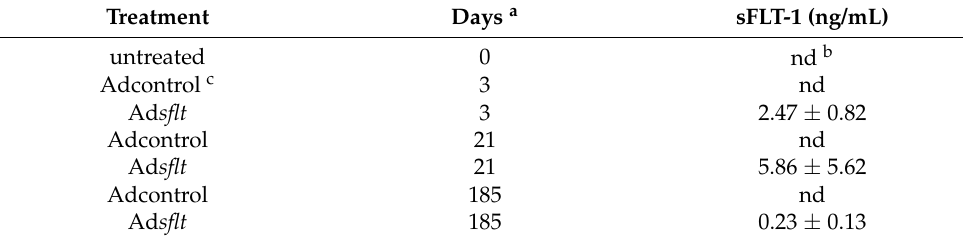
Table 1. Human sFLT-1 serum levels in nude mice bearing Ad vector-injected mammary tumors. Treatment Days a sFLT-1 (ng/mL) untreated 0 nd b Adcontrol